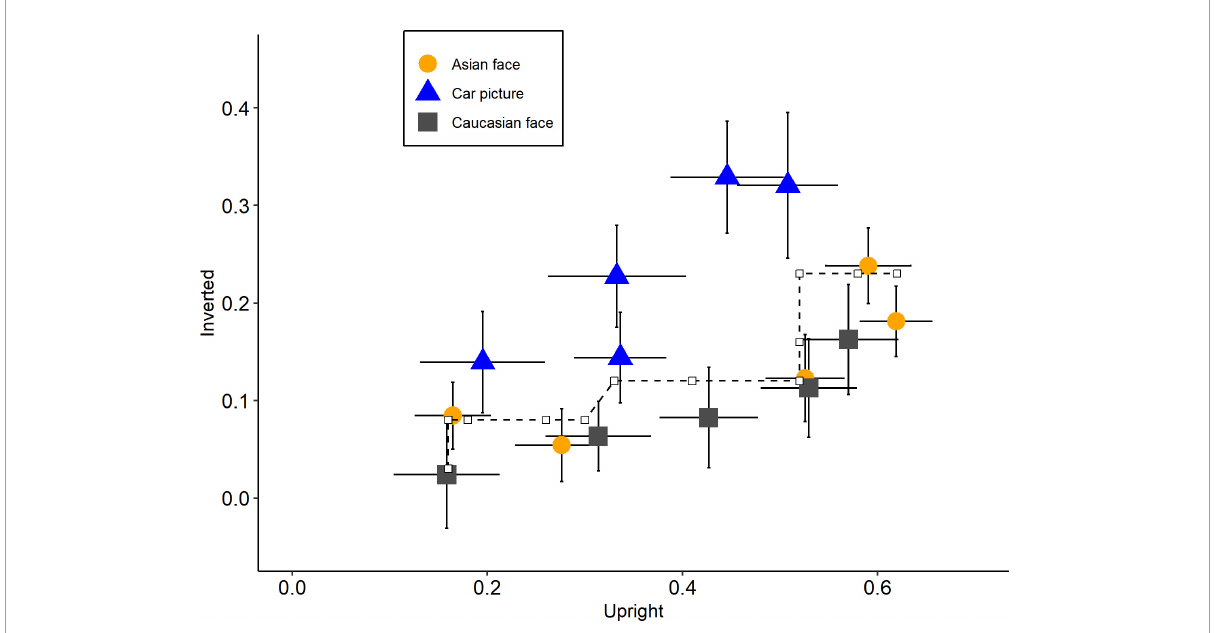
FIGURE5 State trace plot with orientation as state factor. The axis represents the recognition performance ( p r ) of its corresponding stimuli types. Orange circles: Asian faces; Blue triangles: Car front pictures; Gray squares: Caucasian faces. Error bars indicate standard errors and dash line represents the best-fitting monotonic